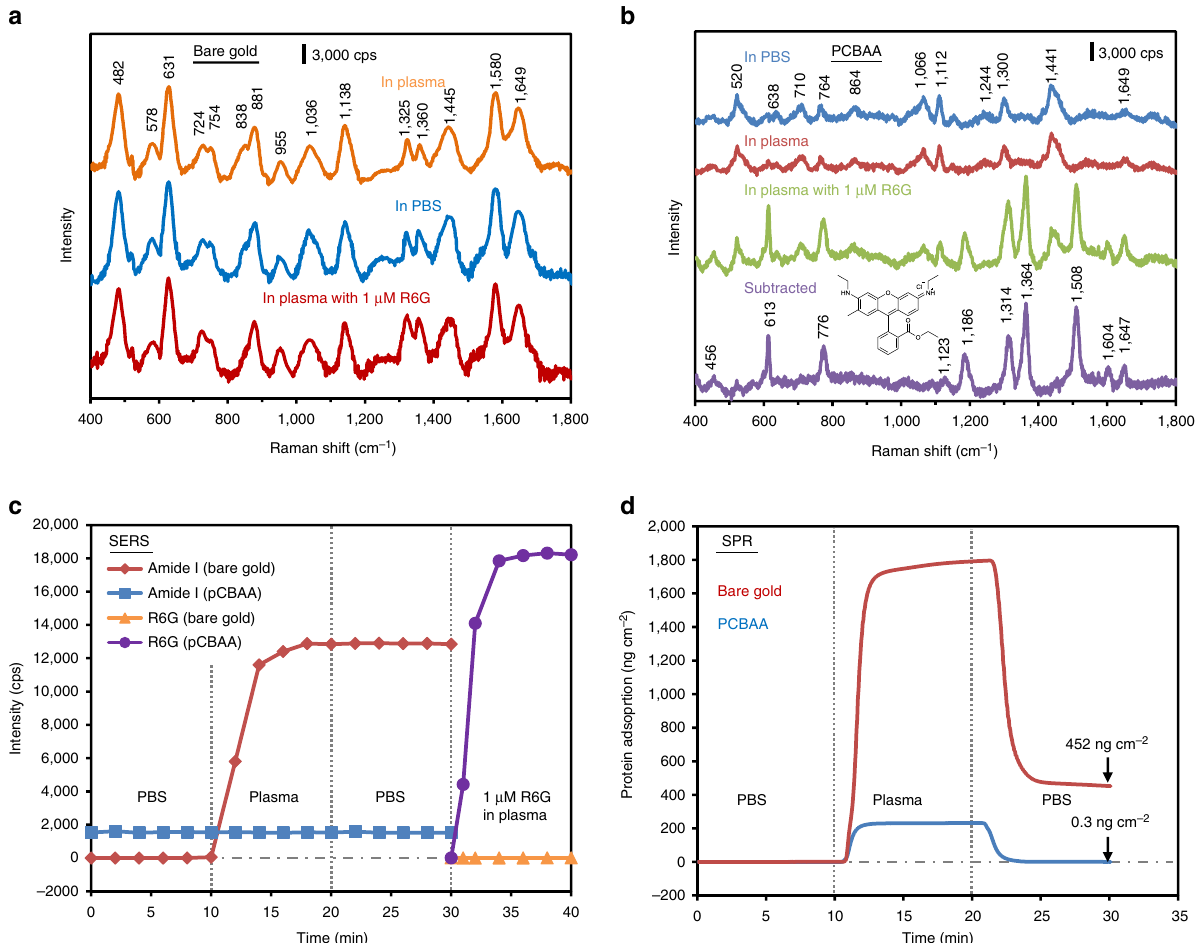
Figure 2 | PCBAA surface modification enabling SERS detection in undiluted human blood plasma. ( a ) SERS spectra acquired with the unmodified SERS optofluidic system. From top to bottom, spectra shown were recorded after flowing undiluted plasma, PBS and plasma spiked with 1 m M R6G each for 10min. ( b ) SERS spectra acquired with the pCBAA-modified SERS optofluidic system. From top to bottom, spectra shown were recorded after flowing PBS, undiluted plasma and plasma containing 1 m M R6G each for 10min, along with the subtracted spectrum from the last two. l ex ¼ 785nm, P laser ¼ 1mW and t ¼ 30s with three accumulations. ( c ) Monitoring plasma protein adsorption and detecting R6G in plasma with the unmodified and pCBAA-modified SERS optofluidic system. Peak intensity of the amide I at 1,649cm (cid:2) 1 for protein and the C–C stretching at 1,508cm (cid:2) 1 for R6G were recorded as a function of time as PBS, plasma, PBS and R6G-spiked plasma were flowed sequentially. ( d ) Typical SPR sensorgram of protein adsorption from undiluted plasma on a bare gold and pCBAA-modified gold surface, showing protein adsorption of 452 and 0.3ngcm (cid:2) 2 , respectively. -quantified concentrations are also plotted in Fig. 3e (purple dashed line). Results from both analytical methods are similar to those reported in medical literature ( B 29%) 30 . In addition, we found our system to be able to distinguish DOX from its metabolite doxorubicinol (DOXol), which shows a new characteristic peak at 1,348 cm (cid:2) 1 (Fig. 3f). In these experiments, we flowed varying molar ratios of DOXol/DOX with a combined concentration of 2 m M and collected SERS spectra (Fig. 3f). The relative intensities of the 1,348 and